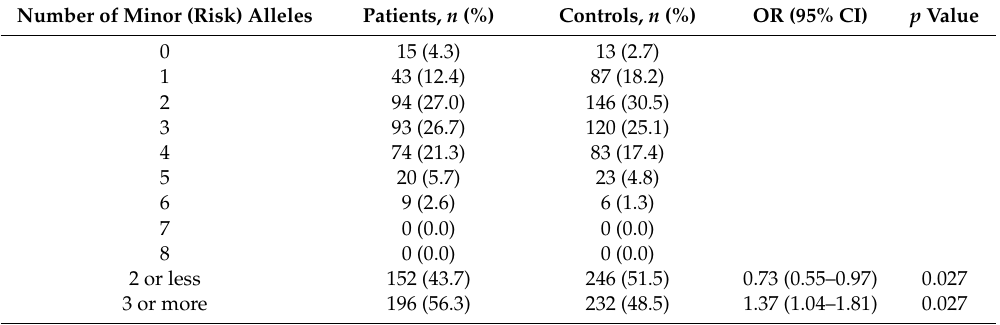
Table 2. Distribution of the number of minor (risk) alleles in type 1 diabetes and